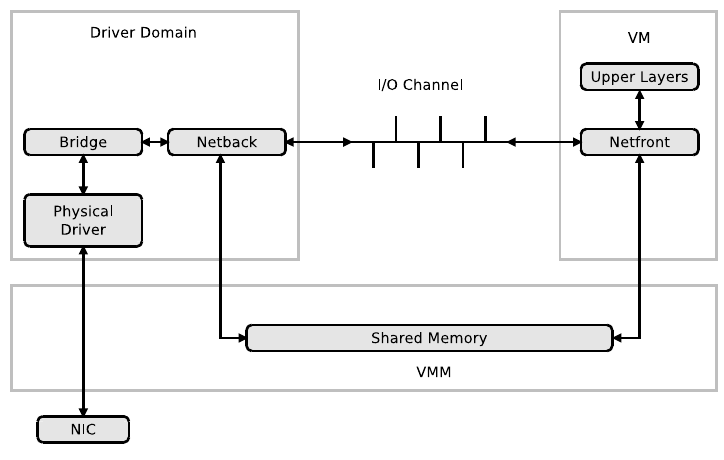
Figure 5. Driver domain based I/O virtualization